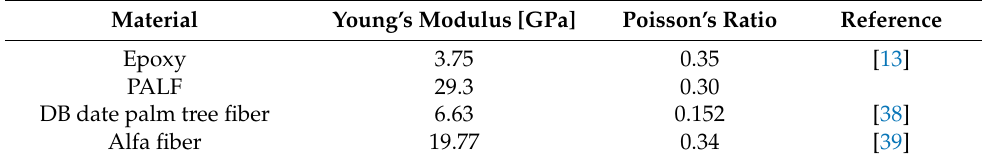
Table 1. Properties of the